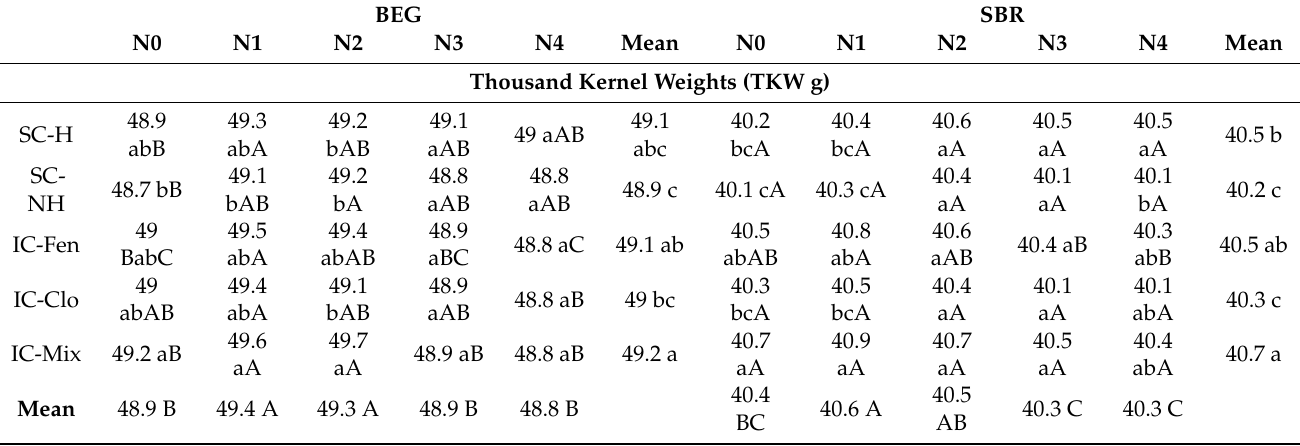
Table 3. Effects of cropping patten and N treatment on thousand kernel weights (TKW), grain protein content (GPC), grain ash content (GAC) and gross grain product impurity rate of durum wheat at both sites averaged over the three seasons.